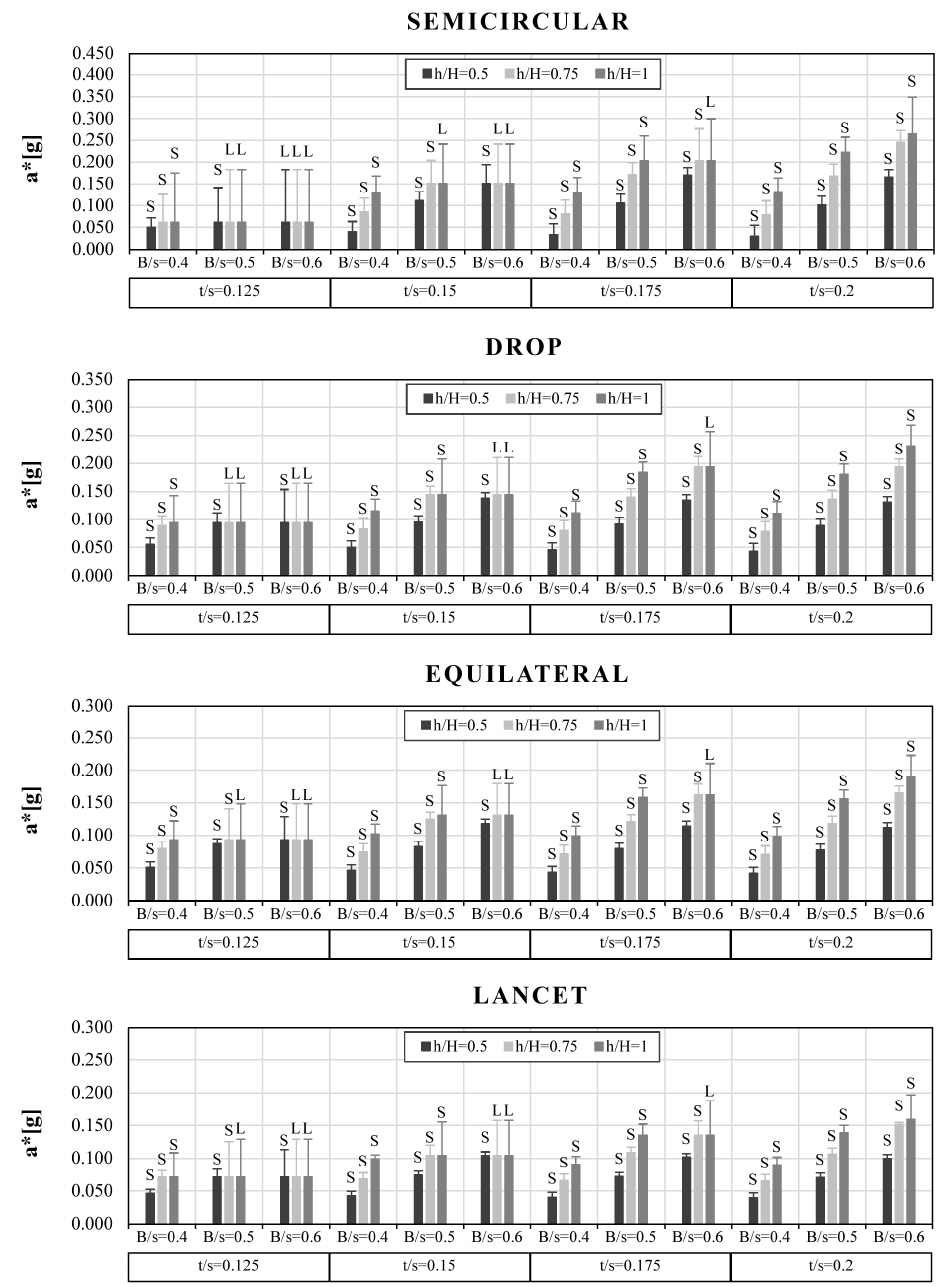
Figure 19. Values of a* [g] of (RI-E) buttressed arches, for each considered eccentricity, t/s ratio, h/H configuration and B/s value. Local mechanism (L) or Semi-global mechanism (S) are